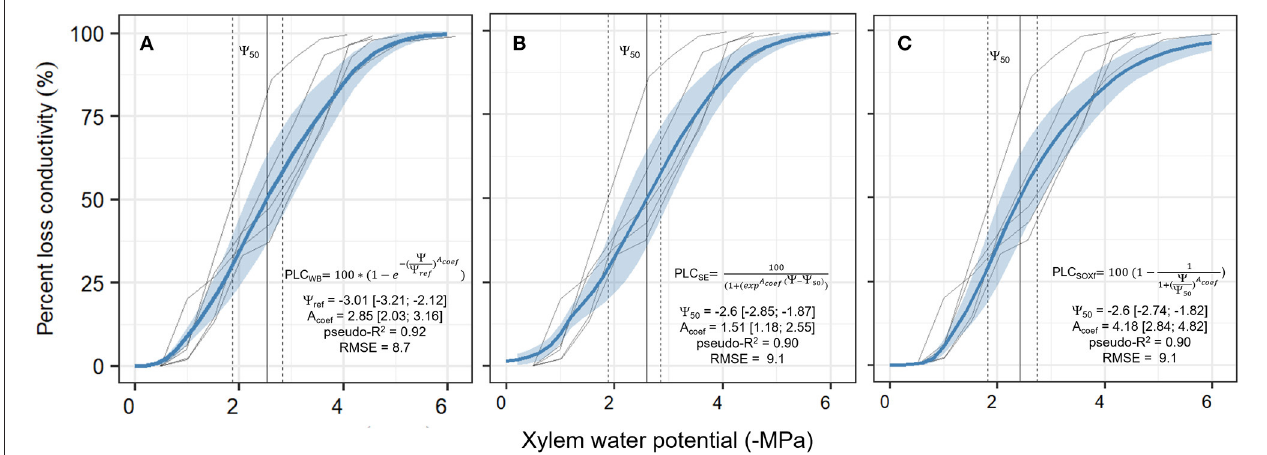
FIGURE 4 | Calibration of the three different xylem vulnerability models [Weibull model (WB, A ), the Sigmoid Exponential (SE, B ), and the original SOX formulation (SOXf, C )] for the P. sylvestris saplings. Solid transparent lines are the five measured curves of the observed percent loss in xylem conductivity (PLC, in %) in relation to xylem water potential decrease ( Ψ xylem , in -MPa). Solid blue line ± shadowed blue area is the median ± 95 CI obtained from 1k model runs sampling the combined posterior parameter estimate, resulting from curve-individual calibrations for each model, as described in section Xylem Vulnerability. The vertical solid line shows the Ψ 50 value; this is when xylem has lost 50% of its conductivity ( ± 95% CI, vertical dashed lines). For each model, formulation and median ± 95% CI values for each parameter are provided. Note that in the WB model Ψ ref parameter meaning is not equivalent to the Ψ 50 parameter from the other two models. Goodness of fit is given as the median pseudo- R 2 and the median root mean square error (RMSE) of all model runs.